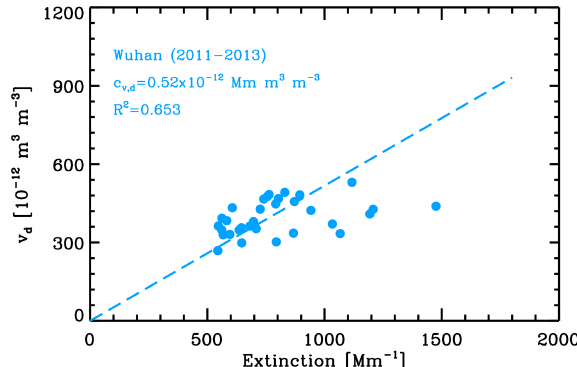
Figure 7. Relationship between extinction coefficient and volume concentration v d for mixed dust. Correlations are given by sun photometer observations during dust-intrusion days that are veri- fied by ground-based polarization lidar. Each point denotes a pair of daily averaged values for the dust occurrence period of a dust- intrusion day. The slope of the dashed blue line indicates the mean increase in v d with extinction coefficient, which is defined as the extinction-to-volume conversion factor c v , d = ( 0 . 52 ± 0 . 12 ) × 10 − 12 Mmm 3 m − 3 . All of the points are obtained from the dust- intrusion days during